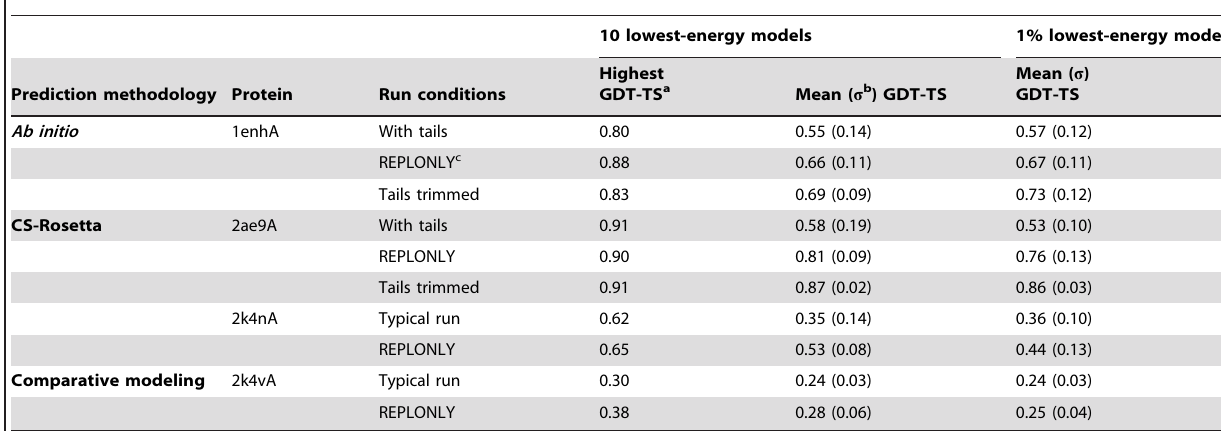
Table 3. Modeling with REPLONLY residues.